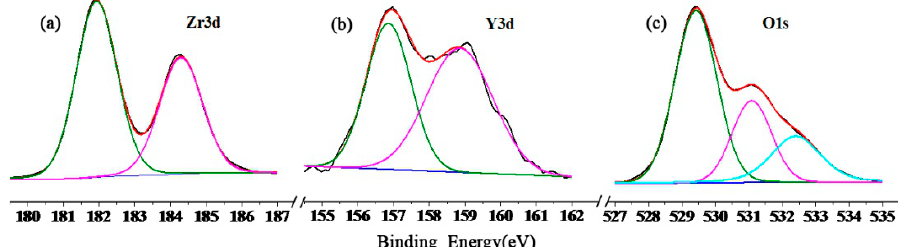
Figure 2. Zr3d ( a ), Y3d ( b ) and O1s ( c ) of the synthesized YSZ-8 catalyst.